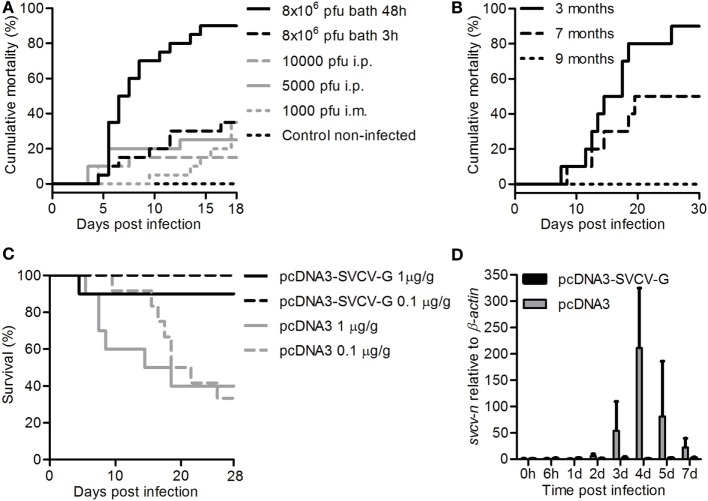
Establishment of a bath challenge for spring viremia of carp virus (SVCV) and validation of a protective DNA vaccine. (A) Carp (n = 20/group) of 3 months were acclimatized to a temperature of 15°C, exposed to the indicated doses of SVCV (VR-1390 strain), for the indicated time, and mortality was recorded. (B) Carp (n = 10) were challenged at 3, 7, or 9 months of age by bath for 30 h at 15°C using 8 × 106 pfu/mL of the CAPM V 539 SVCV strain, and mortality was recorded. (C) Three-month-old carp (n = 10/group) were i.m. injected with 1 µg/g of fish of either pcDNA3 or pcDNA3-SVCV-G and challenged 2.5 months postvaccination, for 48 h at 15°C using 8 × 106 pfu/mL SVCV (VR-1390). In a subsequent experiment, fish were vaccinated with 0.1 µg/g of fish of the same plasmids and challenged as described previously. Survival was monitored over a period of 4 weeks. (D) Carp were treated as in panel (C) using 1 µg/g of fish of DNA plasmid, and upon challenge mid kidneys were isolated at the indicated time points. svcv-n gene expression was analyzed by real-time quantitative PCR. Gene expression was normalized relative to β-actin as a housekeeping gene and expressed relative to the unhandled controls collected at time point 0 h. Data are shown as average + SD of n = 6 fish. Abbreviation: d, day.